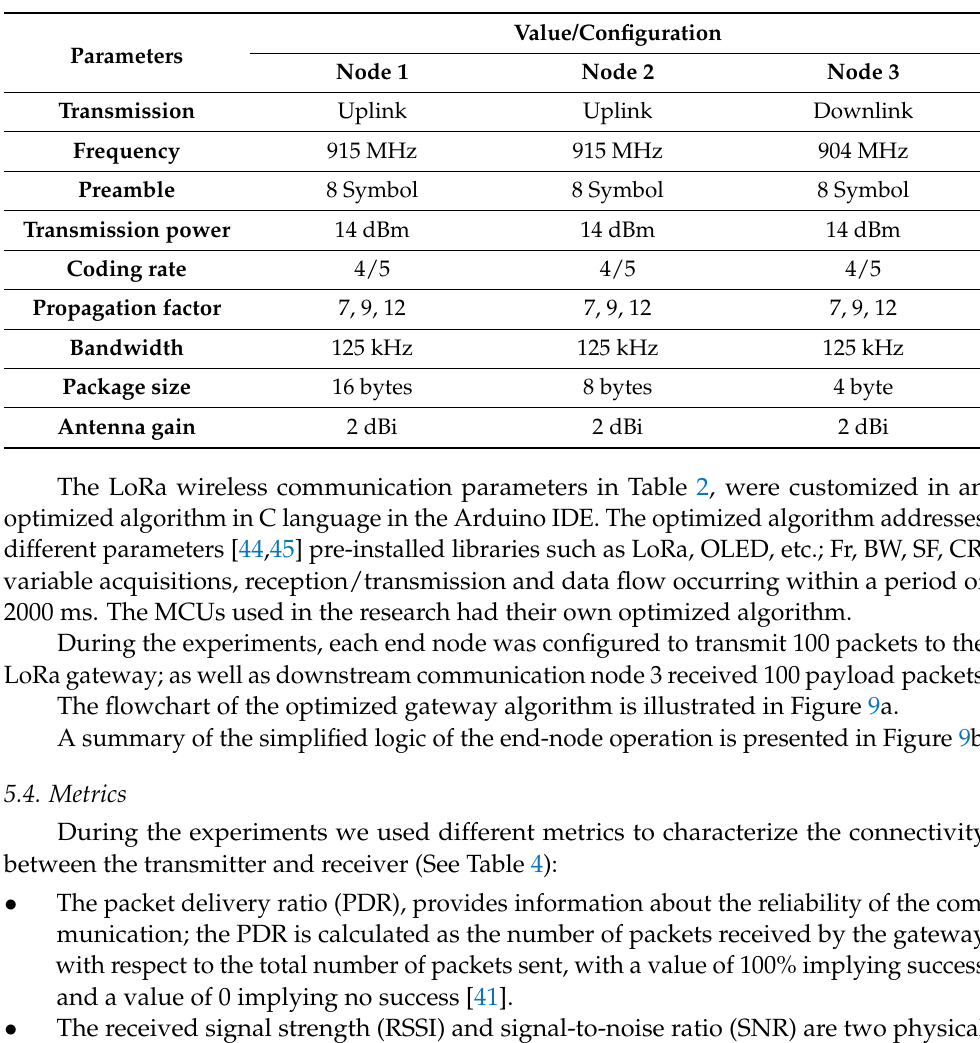
Table 3. LoRa communication